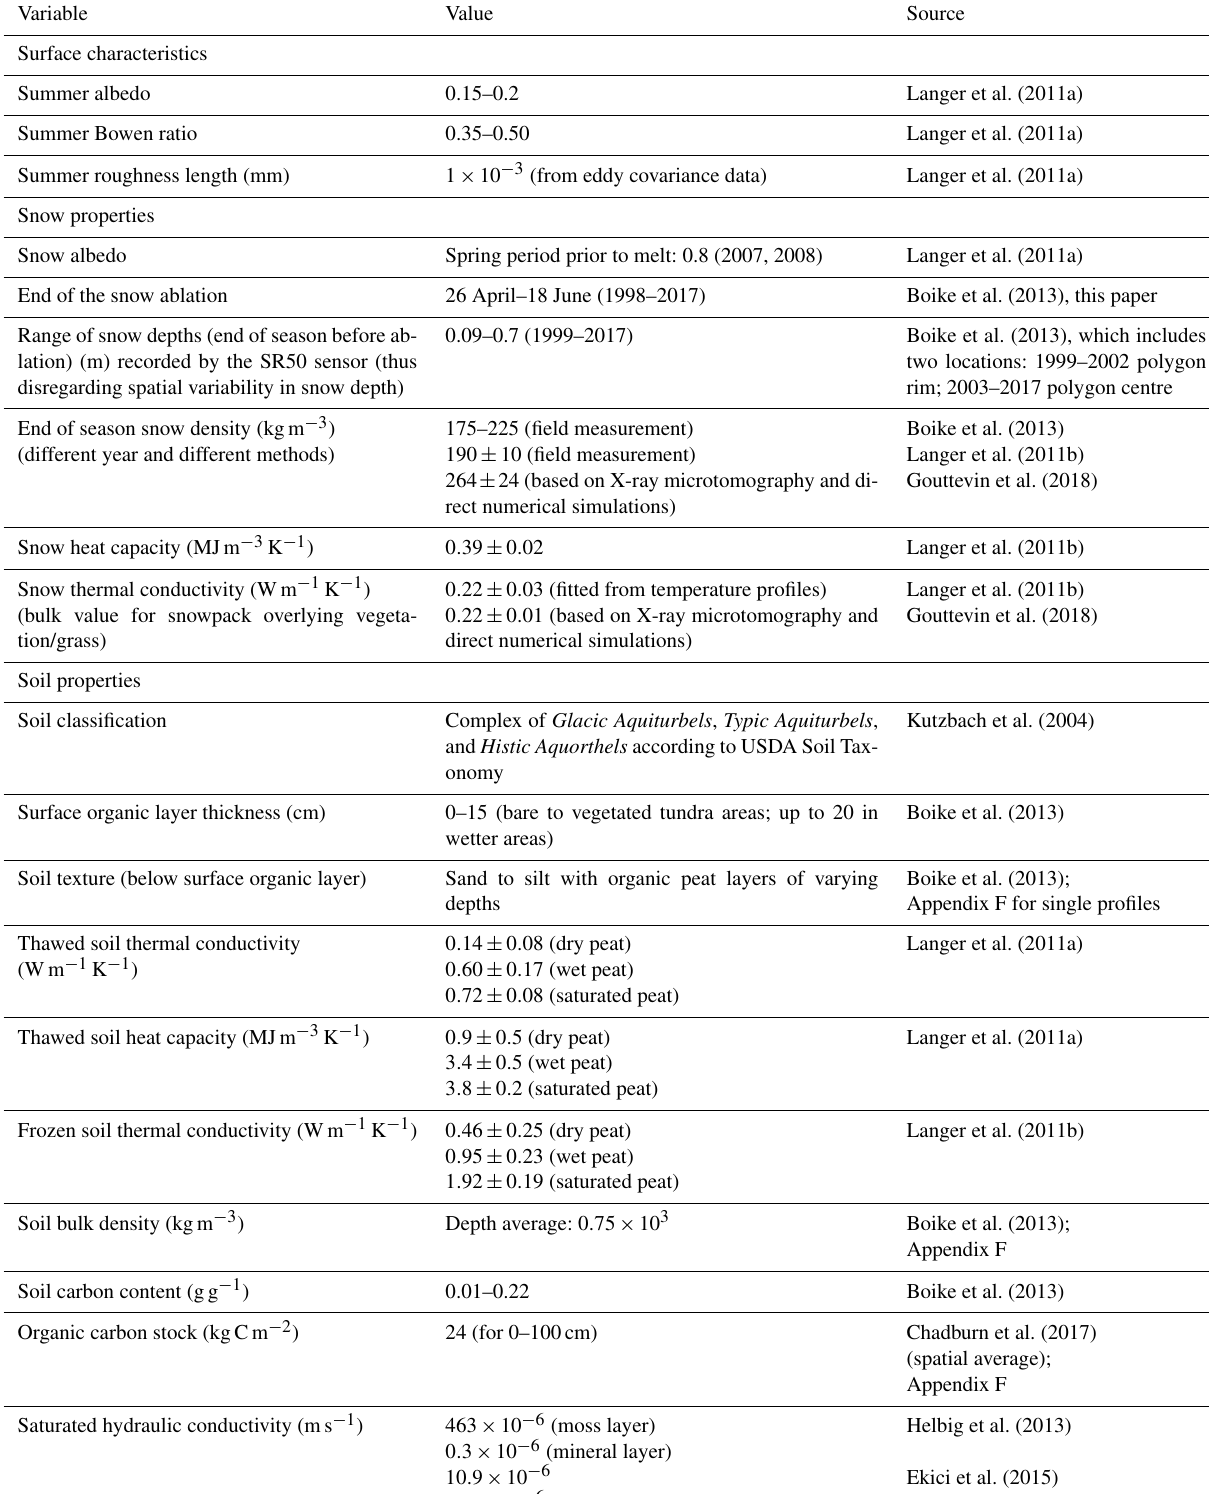
Table 1. Site description parameters for earth system model input. Values have been computed and compiled for the Samoylov research site and surrounding